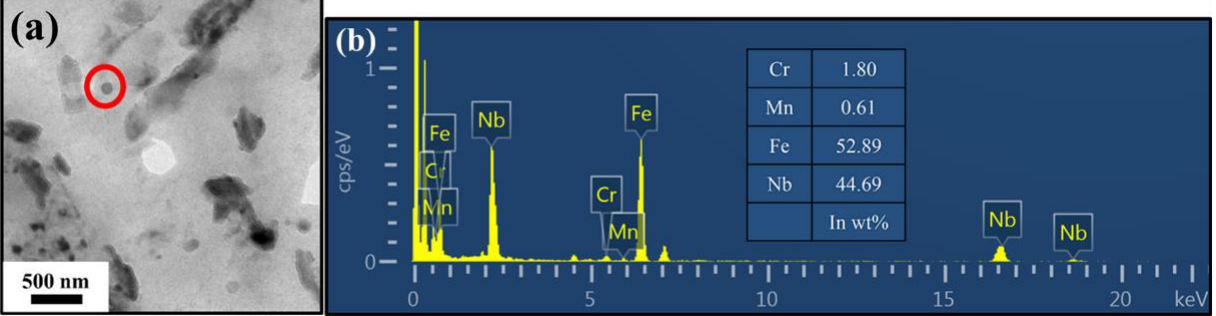
Figure 4. TEM bright-field images of precipitates with two kinds of morphology in martensite ma- trix: ( a ) Steel 2N treated at 900 °C for 10 s; ( b ) Steel 2N treated at 900 °C for 1000 s; ( c ) Steel 3N heat treated at 900 °C for 10 s; ( d ) Steel 3N treated at 900 °C for 1000 s.